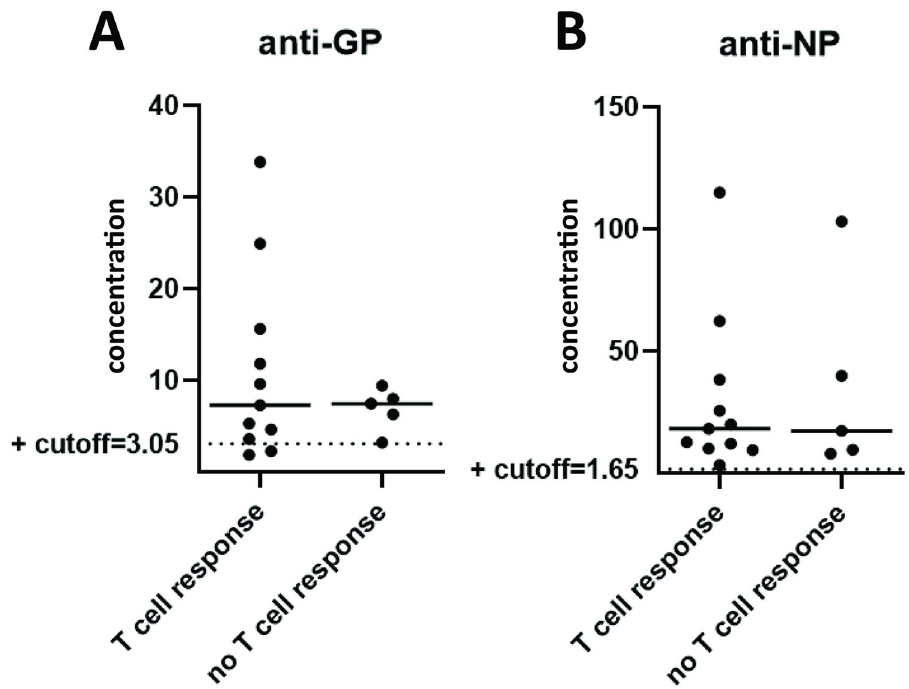
Fig 6. A Anti-GP and B anti-NP antibody levels in LF survivors with and without LASV-specific CD8 + T cell responses on 10-day proliferation assay.